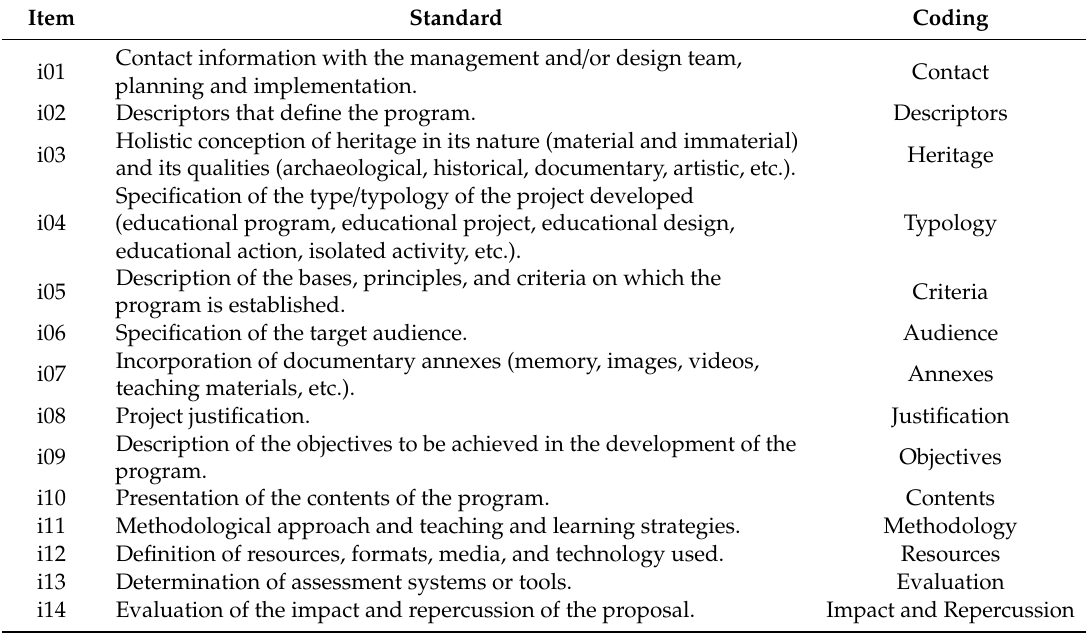
Table 1. Coding of variables according to quality